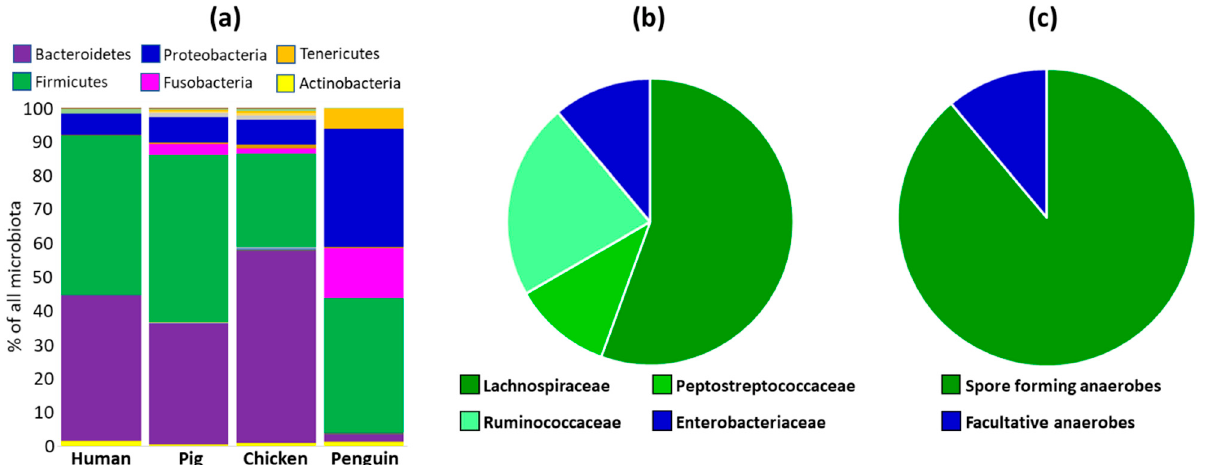
Figure 5. Identification of OTUs present in human, pig, chicken and gentoo penguin microbiota. Panel ( a ), faecal microbiota of wild Antarctic gentoo penguins differed from the microbiota of humans, pigs and chickens as high as the phylum level. Despite this, there were nine OTUs belonging to Lachnospiraceae ( n = 5), Ruminococcaceae ( n = 2), Peptostreptococcaceae ( n = 1) and Enterobac- teriaceae ( n = 1), which were detected in more than half the samples originating from each of the hosts (Panel ( b )). Since Ruminococcaceae, Lachnospiraceae and Peptostreptococcaceae belong to anaerobic spore forming taxa (8 OTUs in total), microbiota members shared among all four hosts were predominantly endospore formers (Panel ( c )).